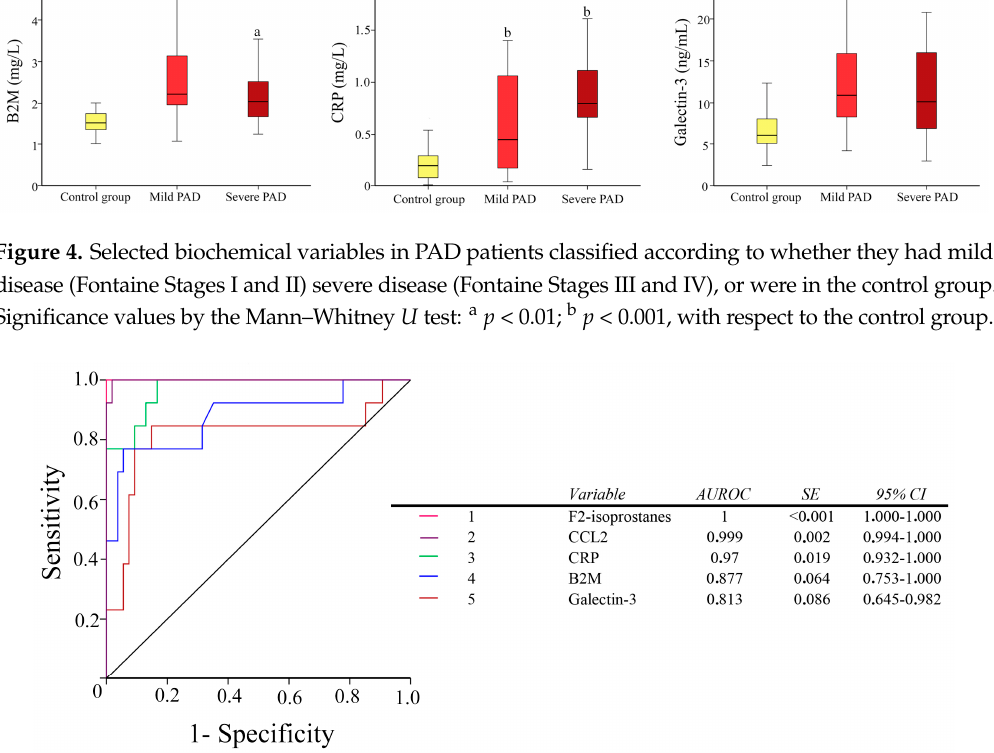
Figure 5. Receiver operating characteristics (ROC) plots for all the studied biomarkers in PAD patients and in the control group. AUROC: areas under the curve of the ROC plots. SE: Standard Error.